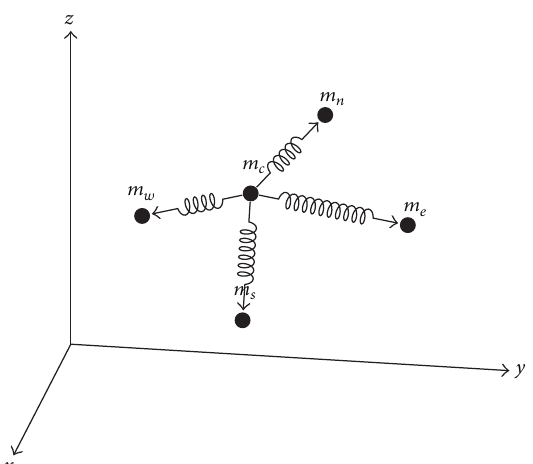
Figure 5: Representation of the central cell and its four orthogonal neighbors forming a Von Neumann CA neighborhood, as well as the direction in which the neighbor force acts, represented by the direction of the vectors.